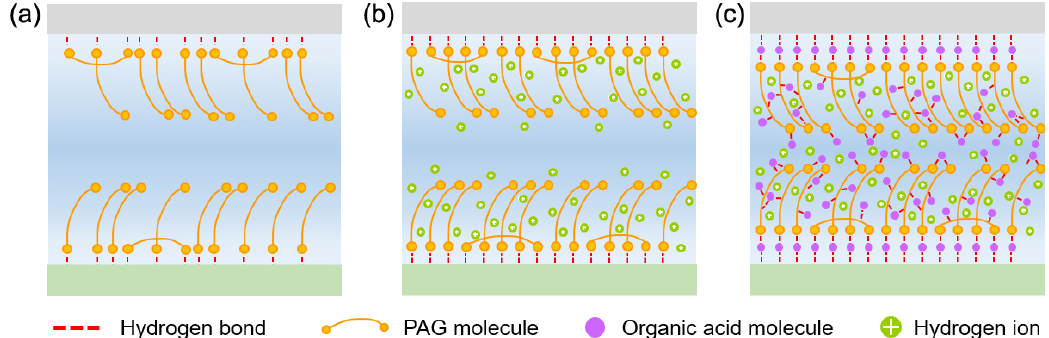
Fig. 7 Schematic illustration of the proposed lubrication models between two sliding solid surfaces for (a) original PAG aqueous solutions, (b) PAG aqueous solutions with inorganic acid, and (c) PAG aqueous solutions with organic